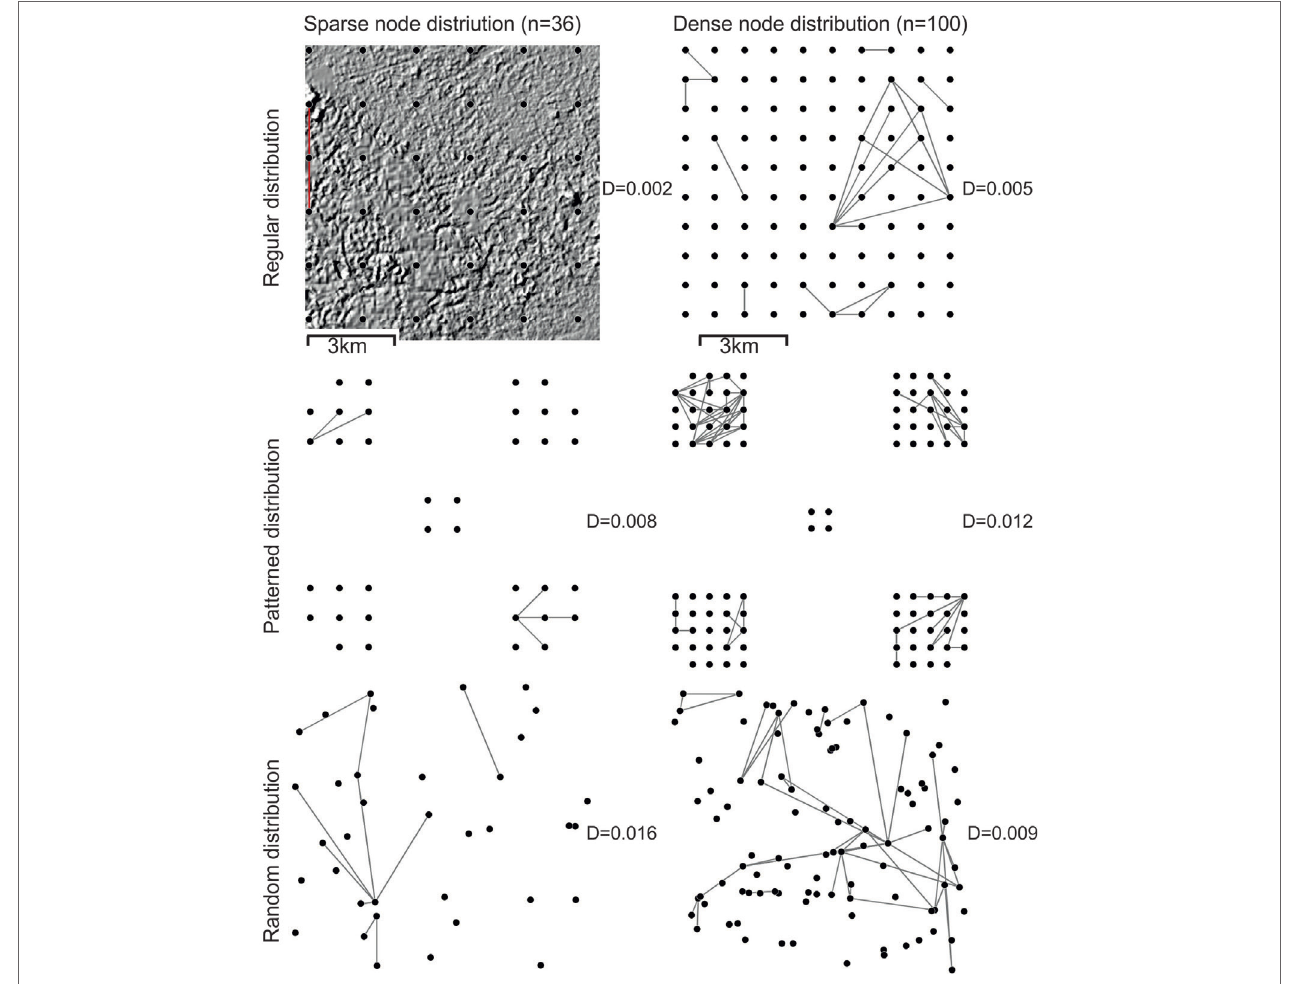
FigUre 7 | Densities (D) of visibility networks between differently distributed observation locations in a hilly landscape (Grande-Terre in Guadeloupe, French West Indies) of 9 km by 9 km. In Figures 7 – 10 , the topography is only illustrated once in the top left to more clearly show differences in network